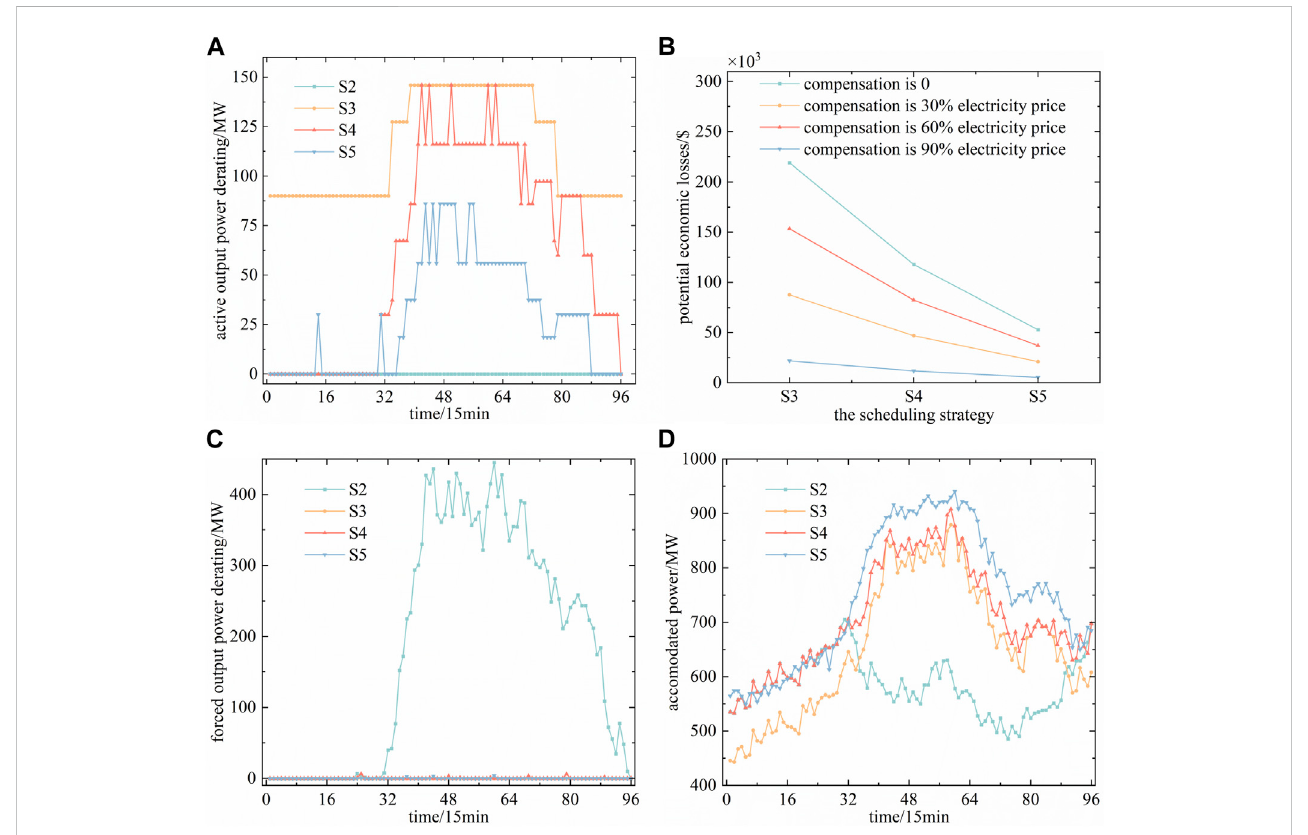
FIGURE 11 Scheduled result of new energy in thefour scheduling strategies: (A) active output power derating, (B) potential economic loss, (C) forced outputpower derating, and (D) accommodated